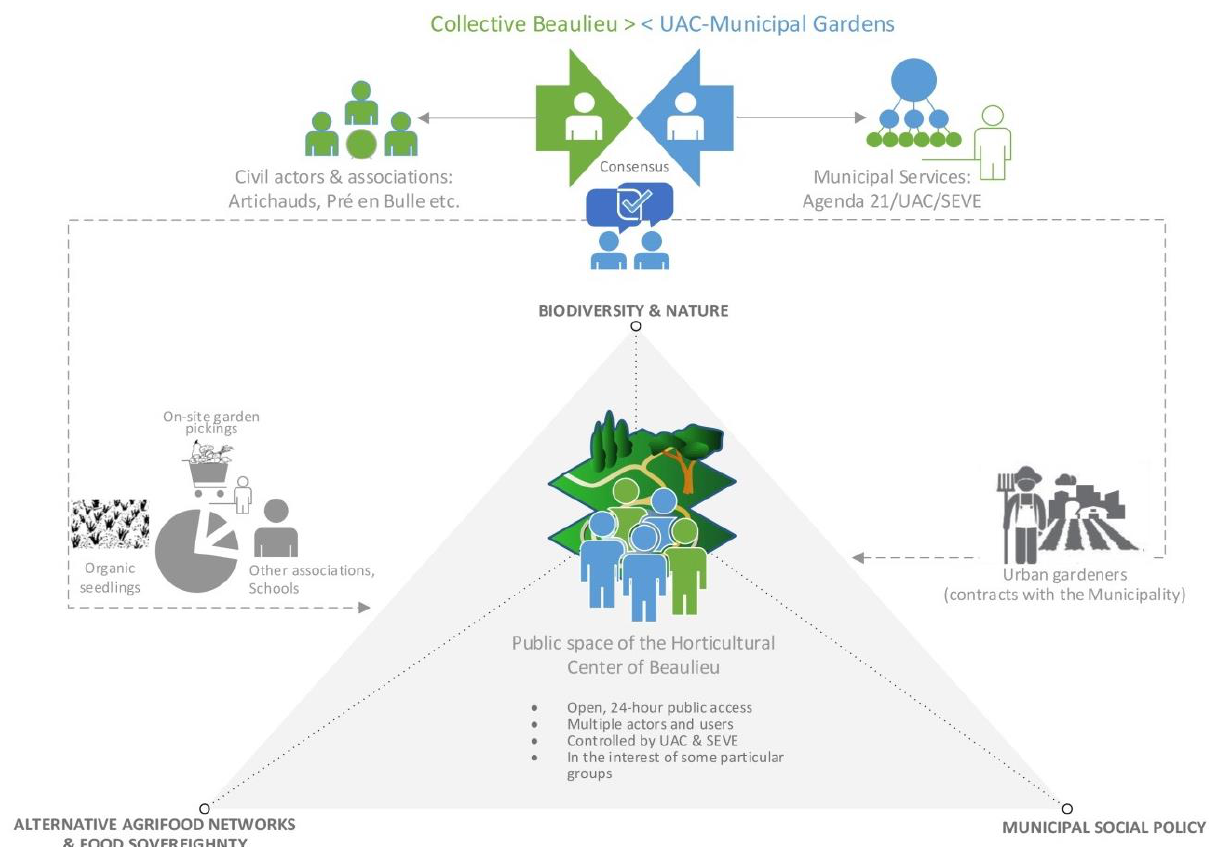
Figure 4 . The Beaulieu example for new collaborative planning practices and the creation of hybrid forms of public space. Source: